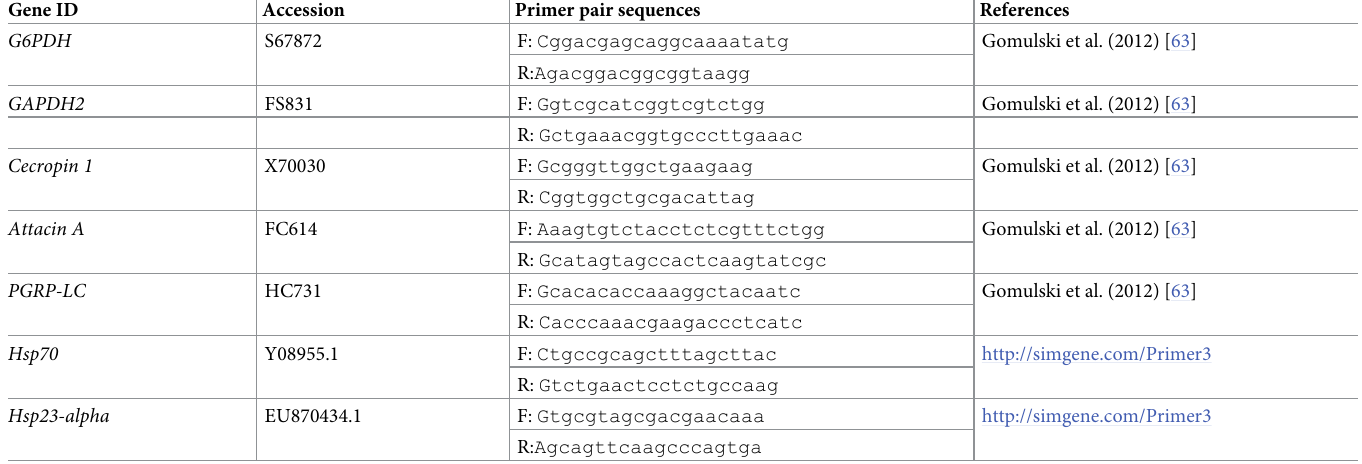
Table 1. Primers used for the qRT-PCR